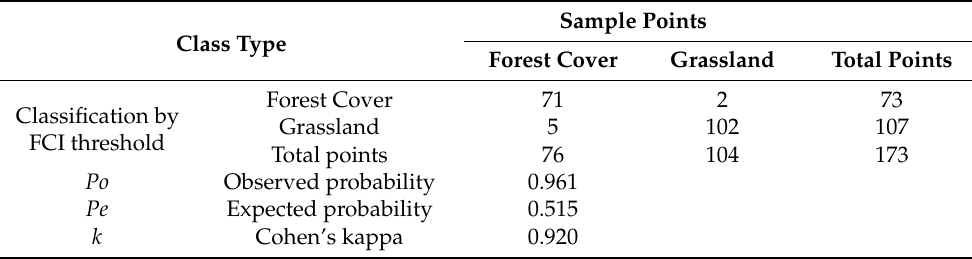
Table 4. Confusion matrix of “forest-grasslands” sample points classification with maximum Cohen’s kappa. Sample Points Class Type Forest Cover Grassland Total